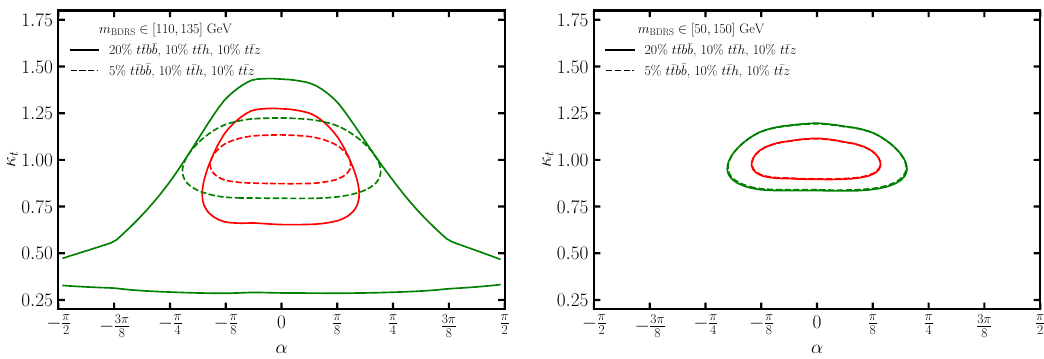
Figure 4 . The exclusion at 68% (red) and 95% (green) CL in the α - κ t plane at the 14 TeV LHC with 3 ab − 1 for a narrow (left) and wide (right) mass window. 20% systematics (5%) for t ¯ tb ¯ b is assumed in solid (dotted) curves, while 10% systematics is used for both t ¯ tZ and t ¯ th